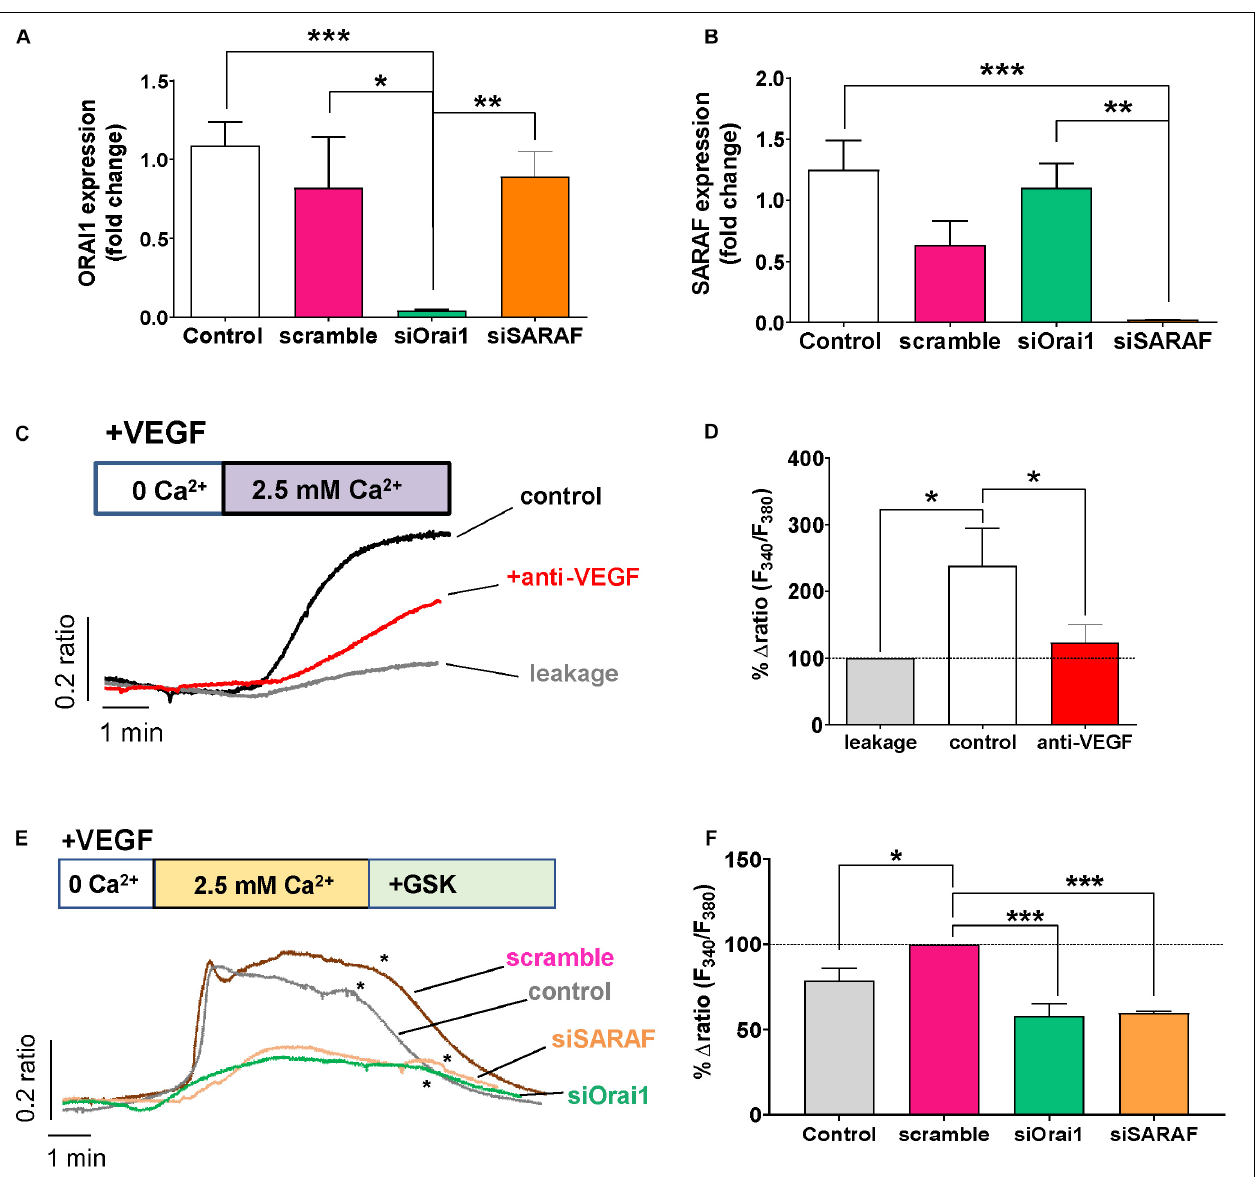
FIGURE 4 | Role of Orai1 and SARAF in VEGF-induced Ca 2 + entry. (A,B) Bar graphs show levels of mRNA expression (log fold change) of Orai1 (A) and SARAF (B) in control HUVECs (white, n = 8) and in cells transfected with scramble (pink, n = 4), siRNA Orai1 (green, n = 5), and siRNA SARAF (orange, n = 5). (C) Representative recordings of VEGF-induced changes in the [Ca 2 + ] i expressed as fluorescence ratio (F 340 /F 380 ). HUVECs were incubated with 30 ng/ml VEGF (control) and with anti-VEGF (+ anti-VEGF) for 5 min in a free Ca 2 + solution; 2.5 mM Ca 2 + was re-added as indicated. Gray trace shows representative recording of non-specific Ca2 + entry in non-treated HUVECs after Ca 2 + addition. (D) Bar graph shows the percentage of delta ratio increase after and before adding Ca 2 + normalized to leakage (gray, n = 164) in cells treated with VEGF (white, n = 200) and in those incubated with VEGF + anti-VEGF (red, n = 255). (E) Representative recordings of VEGF (30 ng/ml)-induced changes in [Ca 2 + ] i in control HUVECs and those transfected with scramble siRNA or with Orai1 and SARAF siRNA. (*) indicates the addition of GSK-7975A (10 µ M) at the end of each experiment. (F) Bar graph shows the percentage of delta ratio increase normalized to scramble (pink, n = 168 cells) after and before adding Ca 2 + into non-transfected control cells (gray, n = 236 cells) and in cells transfected with siRNA Orai1 (green, n = 168 cells) and SARAF (orange, n = 115 cells). Values are presented as the means ± S.E.M. Significance is indicated by (*) for p < 0.05, (**) for p < 0.01, and (***) for p <